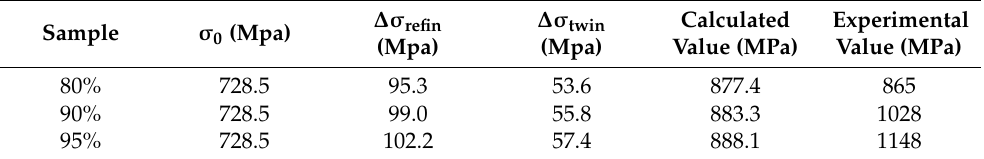
Table 6. The contributions of grain refining and strain-induced twinning, and the calculated and experimental values of the yield